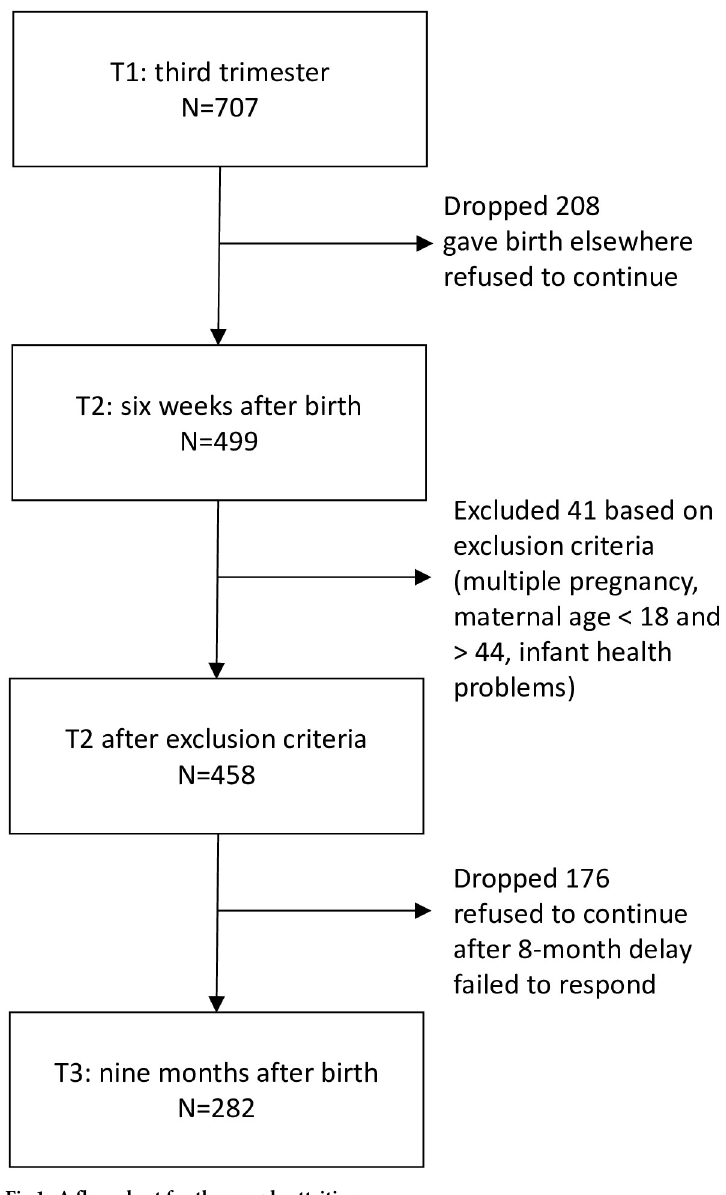
Fig 1. A flow-chart for the sample